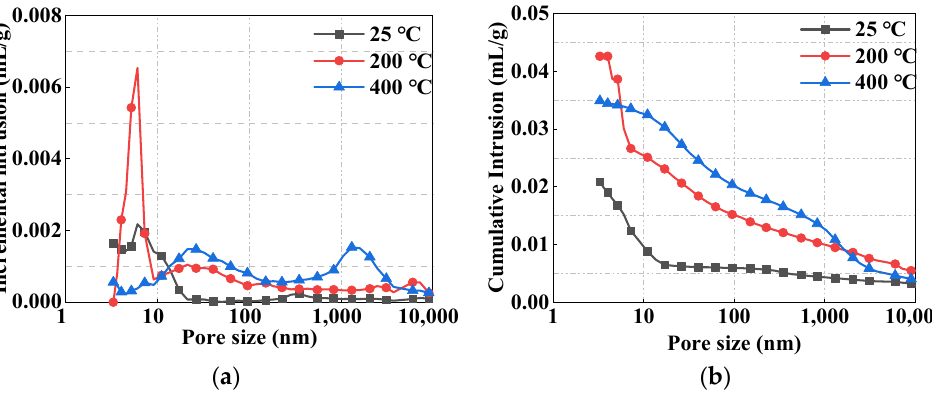
Figure 12. Micropore structures of R100 after high-temperature exposure. ( a ) Differential pore size distribution. ( b ) Cumulative pore size distribution.